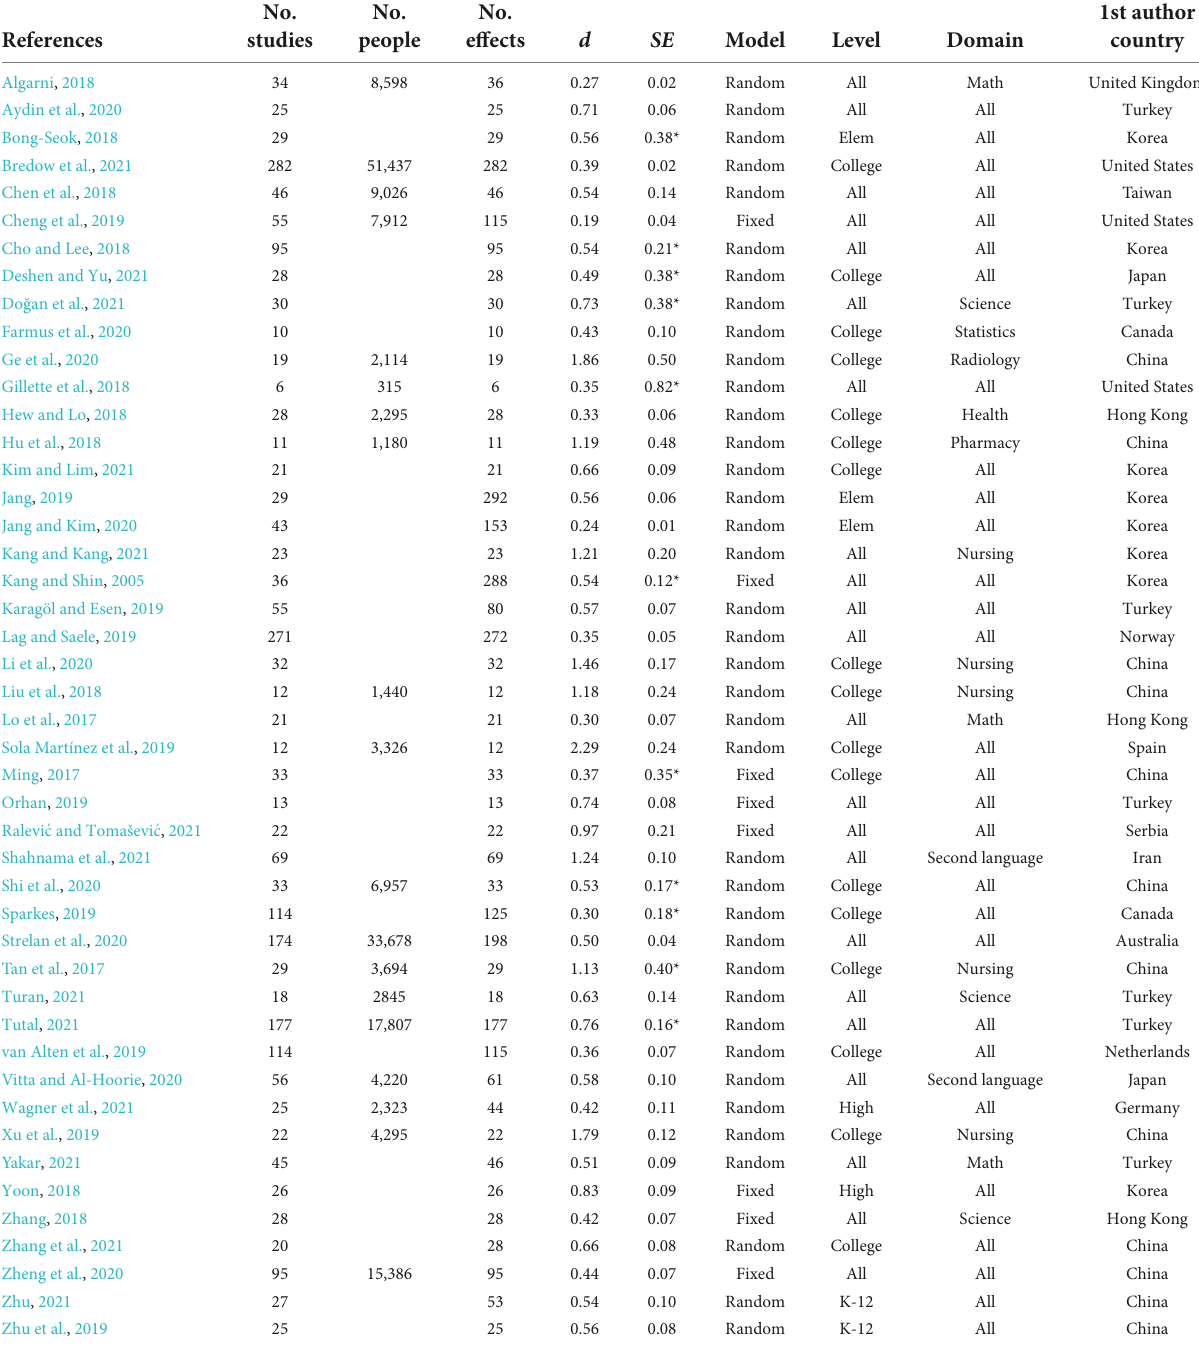
TABLE 1 Summary information from 46 meta-analyses on flipped learning.